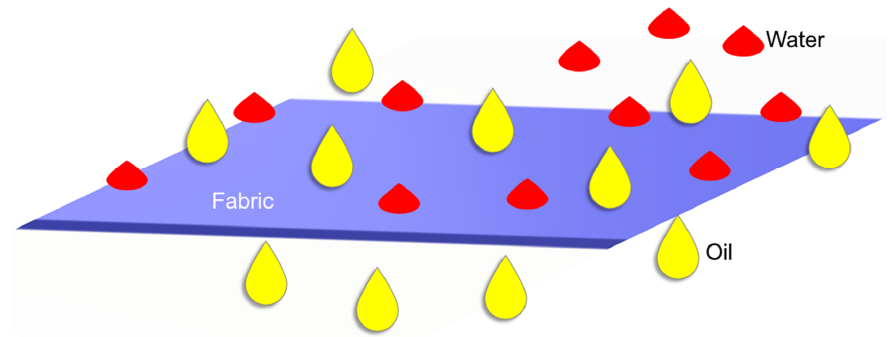
Figure 9. Oil/water separation principle. Figure 9. Oil / water separation principle.